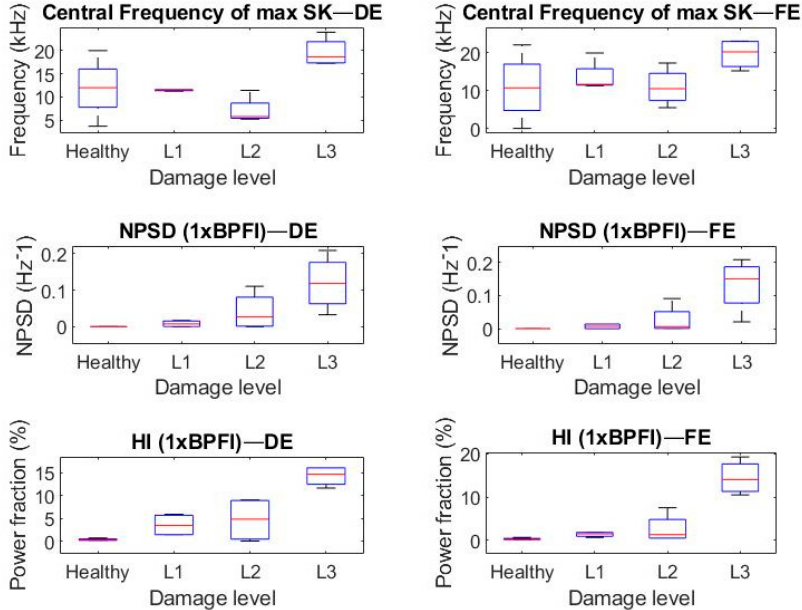
Figure 22. Boxplots for the features extracted from the vibration signal: central frequency of the maximum SK band, 1x BPFI content in the NPSD and HI in the 1x BPFI .